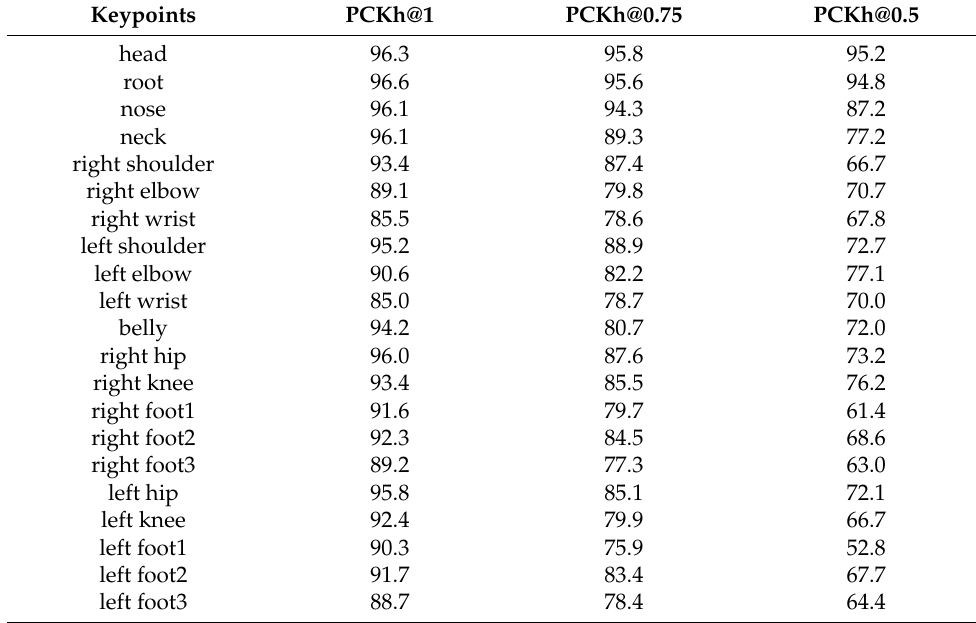
Table 1. Accuracy (%) of the 2D backbone, i.e., the percentage of corrected keypoints (PCKh) considering different threshold values: 1, 0.75, and 0.5 times the head bone link ( PCKh @1, PCKh @0.75, and PCKh @0.5,